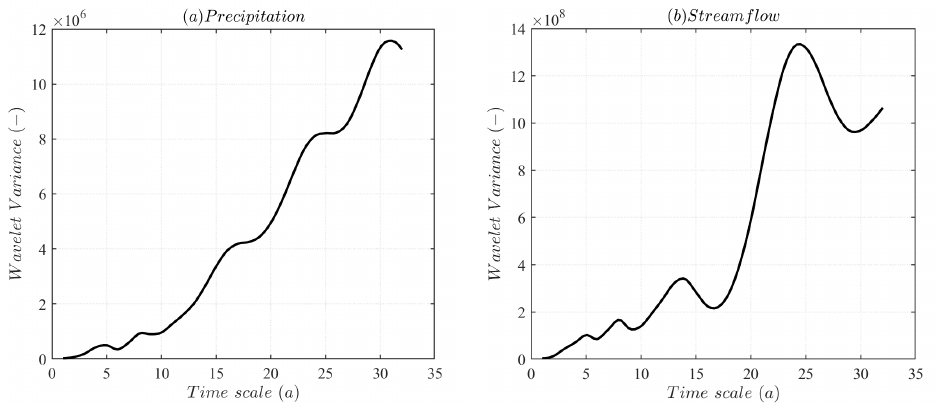
Figure 5. Wavelet variance maps of annual precipitation and annual streamflow series. ( a ) Precipita- tion (1951–2020); ( b ) Streamflow (1900–2020).